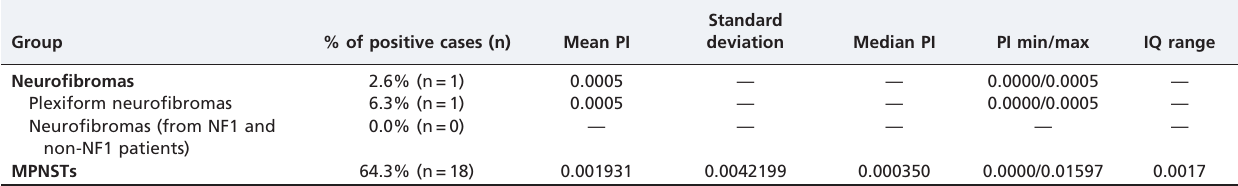
Table 3 - Immunohistochemical data of neurofibromas and malignant peripheral nerve sheath tumors. Group % of positive cases (n) Mean PI